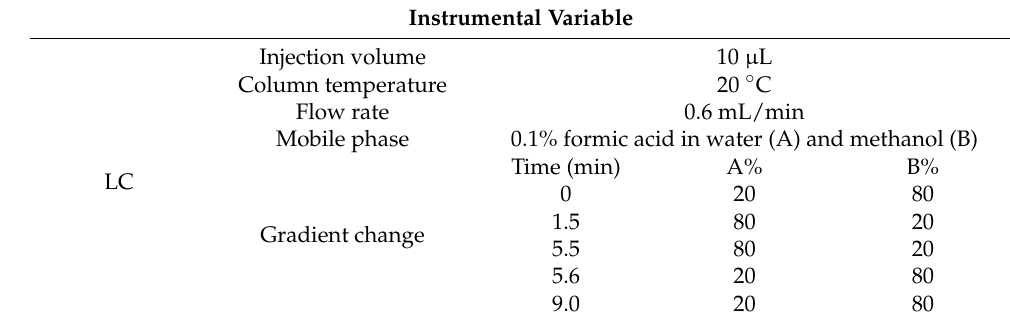
Table 6. Instrumental variables in the LC-MS/MS